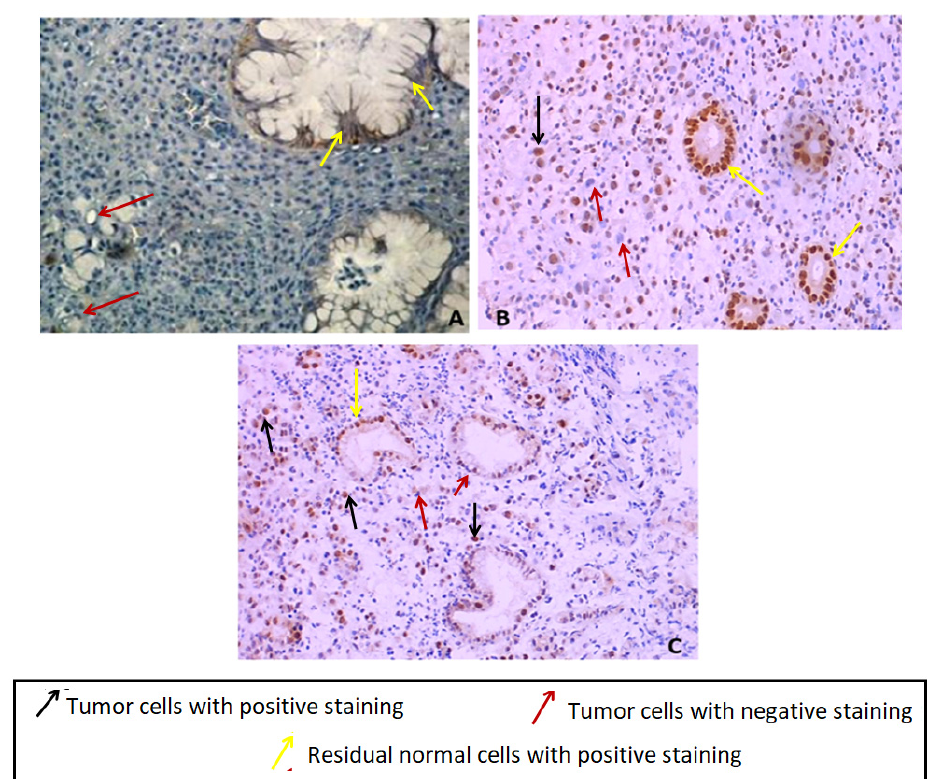
Figure 2. ( A ) Immunostaining of E-Cadherin in index case GC tissues showing a loss of E-cadherin in tumor cells compared to normal glandular adjacent cells showing positive membranous staining ( × 400). ( B ) Nuclear positive immunostaining of MLH1 in index case GC tissue ( × 400). ( C ) Uncom- plete nuclear positive immunostaining of MSH2 in index case GC tissue ( × 200) original magnifica- tion.